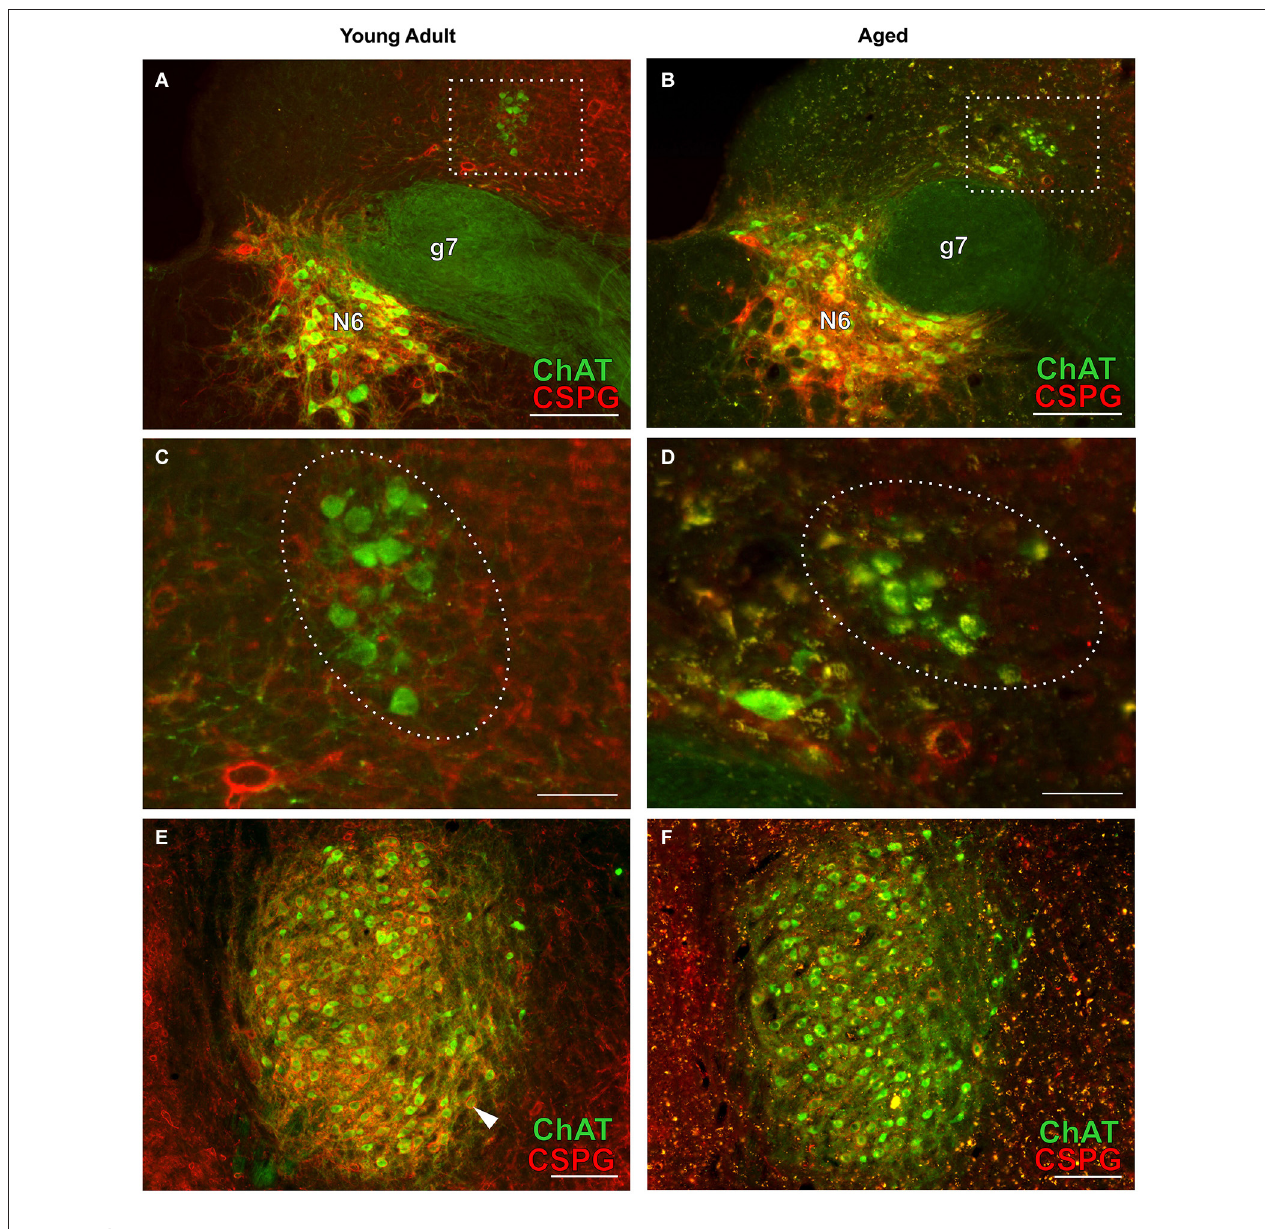
FIGURE 7 | Cholinergic neurons of the efferent vestibular system (A–D) and of the motor trigeminal nucleus (E,F) in young adult and aged gerbils . Micrographs were taken from the same series of a pair of young adult and aged gerbils as for the OC examples in Figure 4 . ChAT (Alexa Fluor 488, green) and CSPG (Cy 3, red) immunolabeling is shown. The group of vestibular efferents in young adult and aged gerbil is accentuated by rectangles in (A,B) . (C,D) show enlargements of the rectangles in (A,B) , respectively.